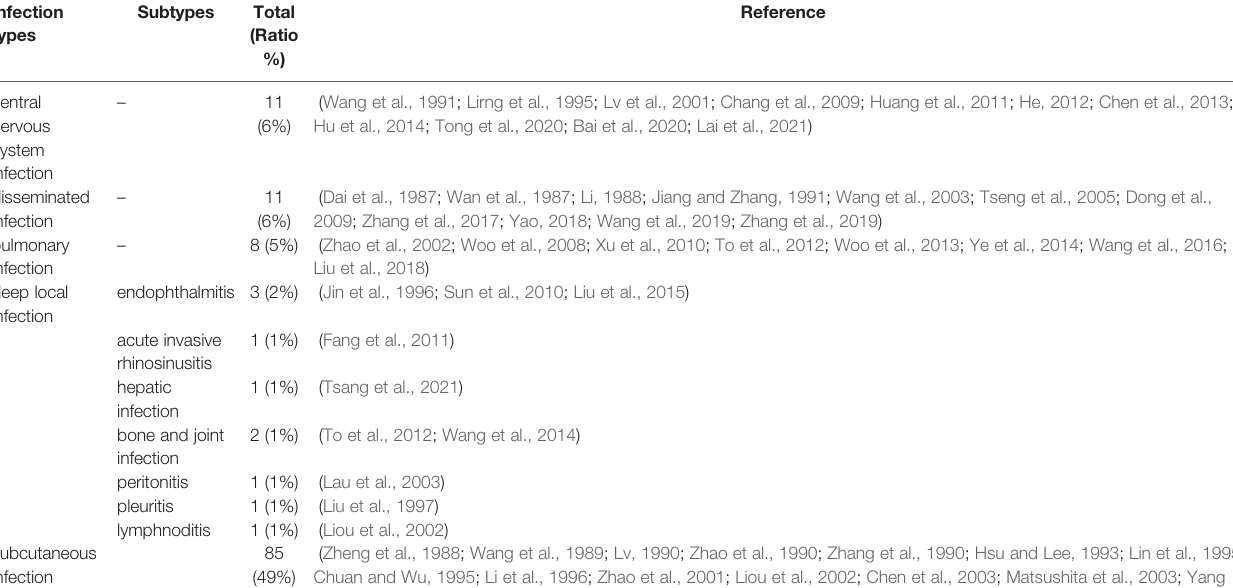
TABLE 2 | Infection types of the phaeohyphomycosis in